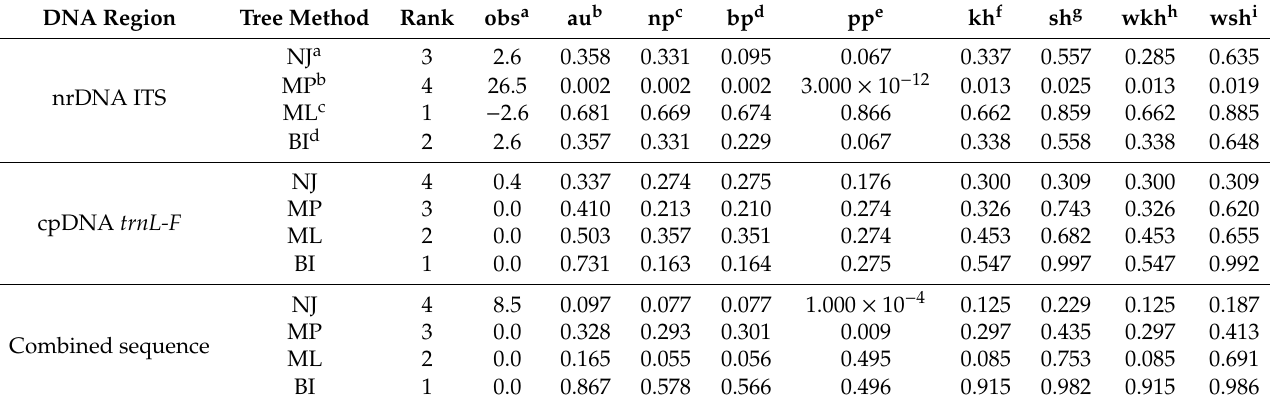
Table 2. The topology compared with four phylogenetic tree construction methods. DNA